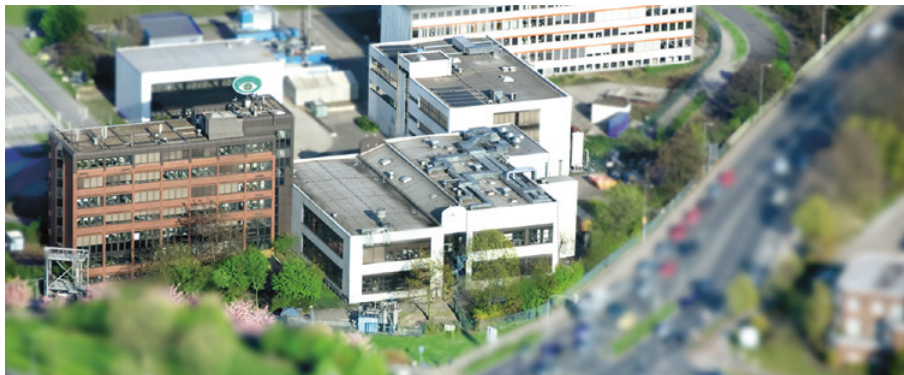
Figure 1: Institute’s complex in Oberhausen. © Fraunhofer